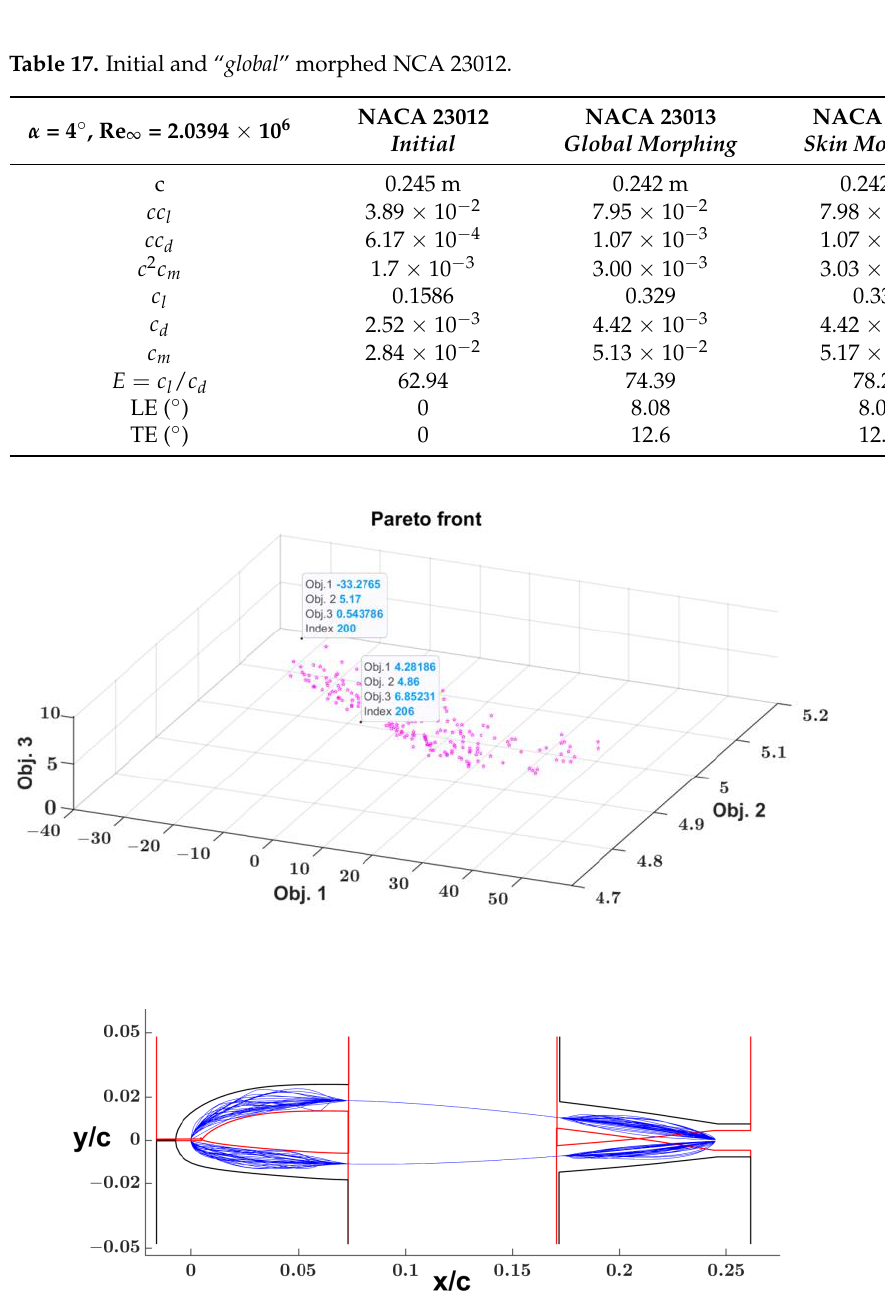
Figure 38. NACA 23012 Pareto front skin optimization ( left ), airfoil local morphing ( right ).